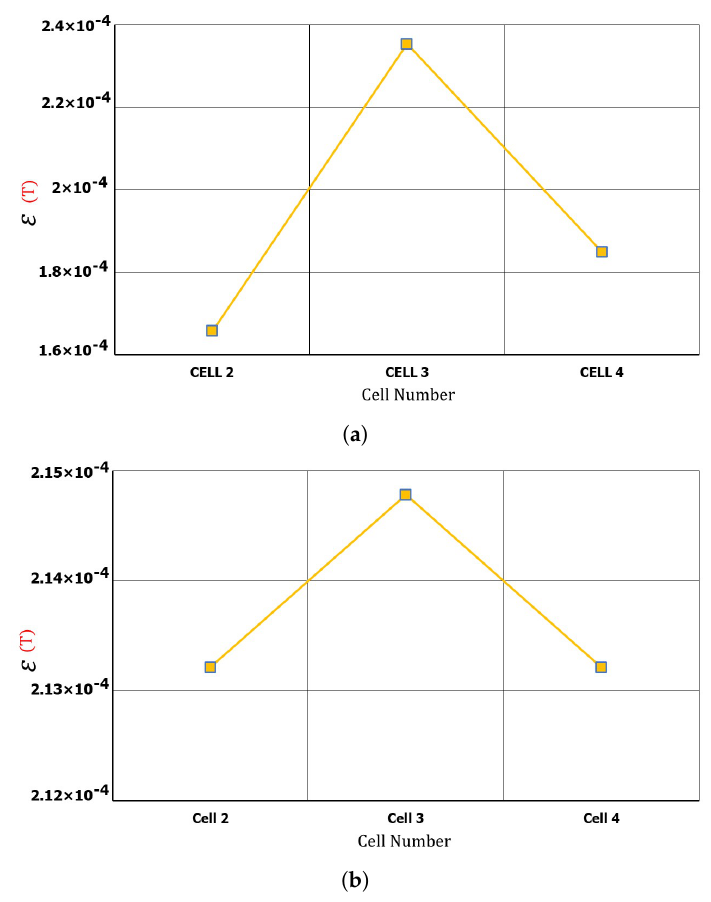
Figure 13. ( a ) Experimental 3D fault detection, ( b ) simulation 3D fault